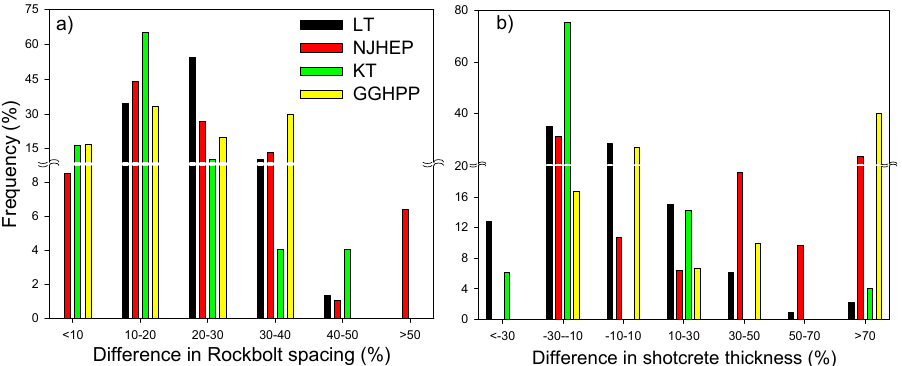
Figure 9. Actual and RMi -suggested support differences in term of ( a ) rock bolt spacing ( b ) shotcrete thickness (positive value on the x-axis indicates that the recommended support is heavier than the actual).